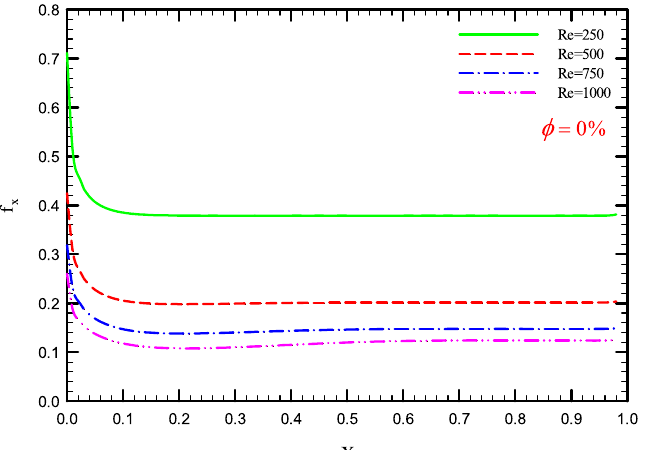
Figure 35. f x versus dimensionless length in φ = 0% for Case 3.